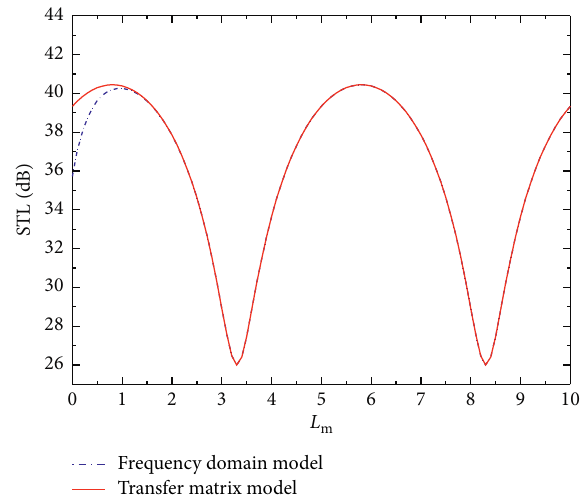
Figure 5: Influence of space between membranes on sound transmission